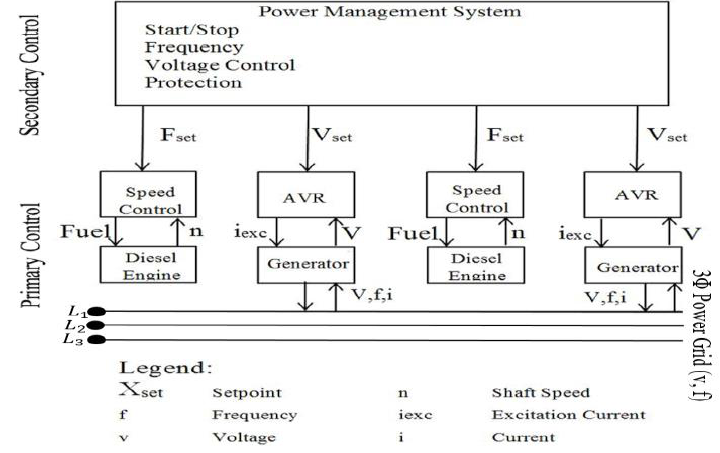
Figure 15. Schematic diagram of a control plan for frequency treatment [114].